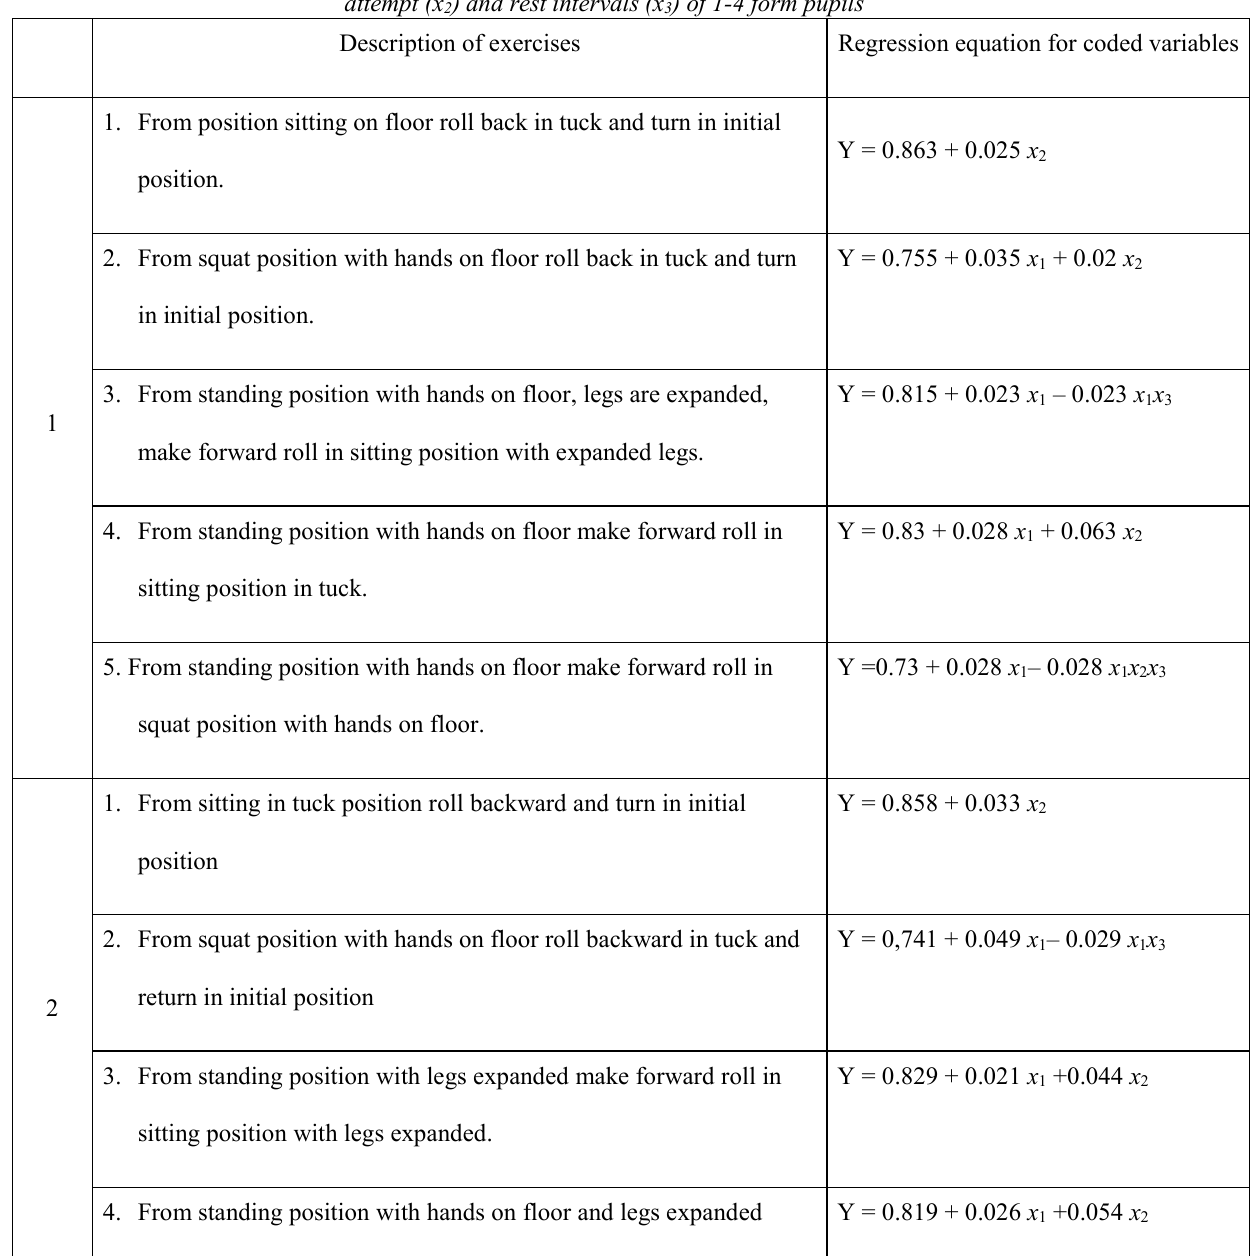
Regressive dependence of fitness in gymnastic exercises on quantity of attempts (х 1 ), quantity of repetitions in